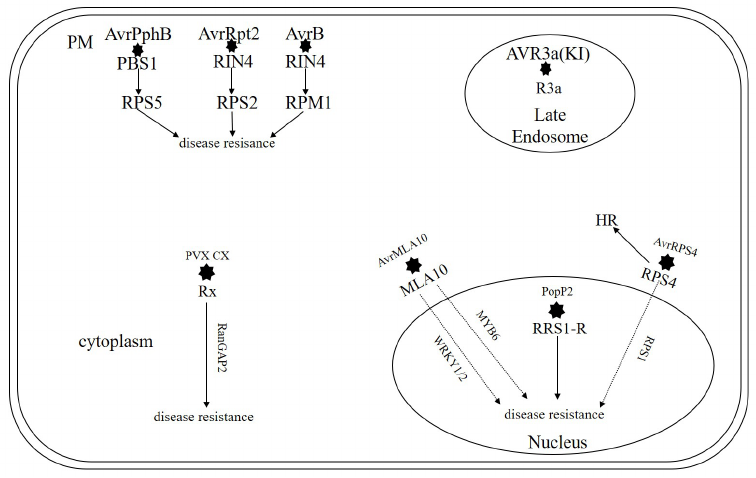
Figure 2. Diversified localization of plant NBS-LRR protein (according to Dong Qi).